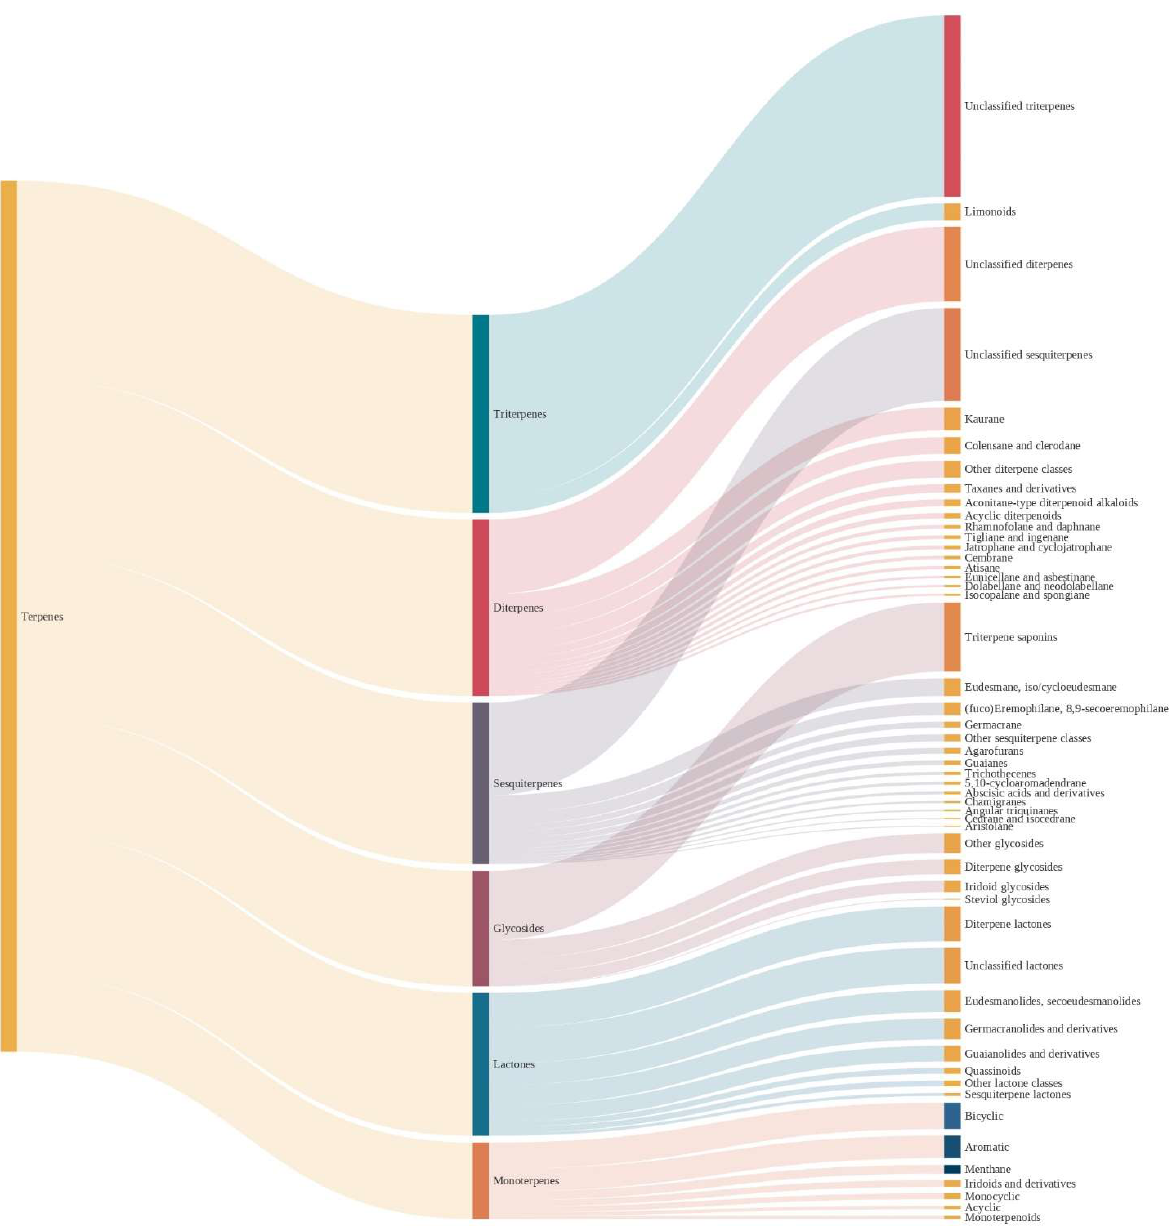
Figure 3. Classification of terpenes in the COCONUT database. The second level of classification corresponds to classical phytochemical subclasses (monoterpenes, diterpenes, sesquiterpenes, among others), while the last level corresponds to characteristic nuclei or subsets.